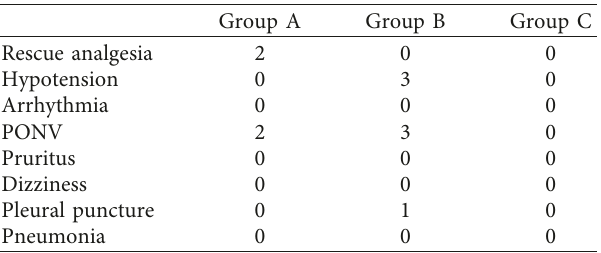
Table 3: Rescue analgesia and complications during the PVB procedure and